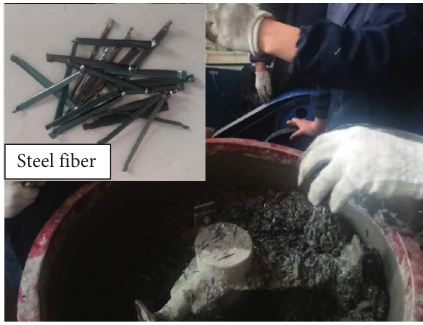
Figure 3: KDR-V5 concrete quick freeze-thaw tester. Figure 1: Steel fiber concrete mixing.